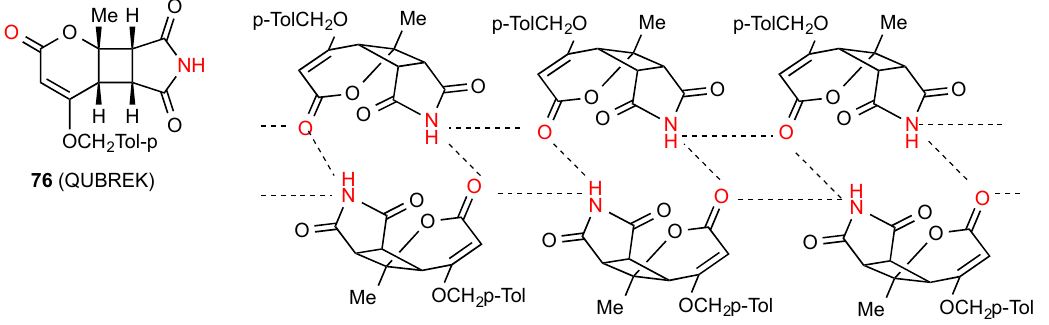
Figure 27. Structure adopted by compound 76.